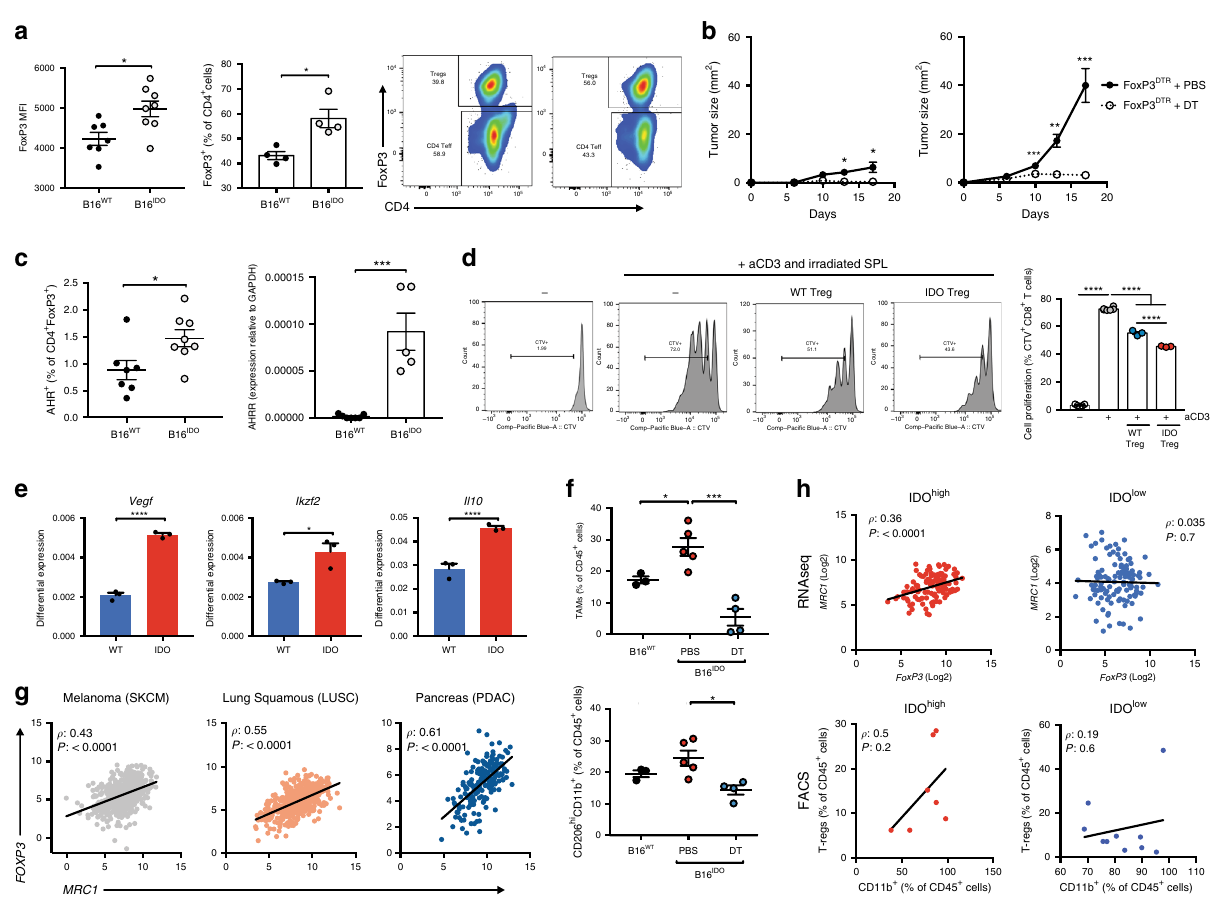
Fig. 3 FoxP3 + T cells co-operate with TAMs in promoting immune suppression of IDO + tumors. a Flow cytometric analysis of FoxP3 expression in tumor-in fi ltrating CD4 + populations (left), and of Tregs (CD4 + FoxP3 + ) (right) ( n = 7 (B16 WT ) and n = 8 (B16 IDO )). Results representative of three independent experiments. b Tumor progression of B16 WT (left) and B16 IDO (right) tumors implanted in FoxP3 DTR mice treated with PBS or DT (1 μ g/ mouse) ( n = 5 per group). c FACS analysis of AHR expression (left) ( n = 7 (B16 WT ) and n = 8 (B16 IDO )) and mRNA analysis by qRT-PCR analysis of AHRR expression in B16 IDO and B16 WT tumor-isolated T-regs (right). d In vitro suppressive activity of tumor-isolated Tregs isolated from B16 IDO or B16 WT - bearing FoxP3 GFP mice. Left: Representative histograms of CD8 + T cell proliferation at a ratio of 1:1 (Effectors:Targets). Right: FACS quanti fi cation of T cell proliferation (CTV low ) ( n = 3). e mRNA of Treg markers by qRT-PCR analysis in tumor-isolated Tregs from B16 WT and B16 IDO tumors ( n = 3). f FACS analysis of TAMs (top) and M2-like myeloid populations (CD206 high CD11b + ) (bottom) in B16 IDO tumors after Treg depletion in FoxP3 DTR mice injected with DT (1 μ g/mouse) or PBS (B16 WT n = 3; B16 IDO PBS n = 4, DT n = 5 mice/group). g Correlation analysis between myeloid marker (MRC1/CD206) and Treg marker (FoxP3) in TCGA RNAseq data of of skin melanoma (SKCM), squamous lung (LUSC) and pancreatic adenocarcinoma (PDAC). h Correlation analysis in TCGA RNAseq data of IDO high and IDO low skin melanomas (SKCM) analyzed by Spearman rank correlation. Bottom: correlation analysis between frequency of Tregs (CD4 + FoxP3 + ) and myeloid cells (CD11b + ) in FACS analyzed IDO high and IDO low melanoma patients ’ biopsies by Spearman rank correlation. Results in (b – f) are representative of two independent experiments. Data is represented as mean values ± SEM. Two-tailed unpaired Student ’ s t test was used when only two groups were compared, and one-way ANOVA was applied with comparison of more than two groups. P value: * P < 0.05, ** P < 0.01, *** P < 0.001, **** P <